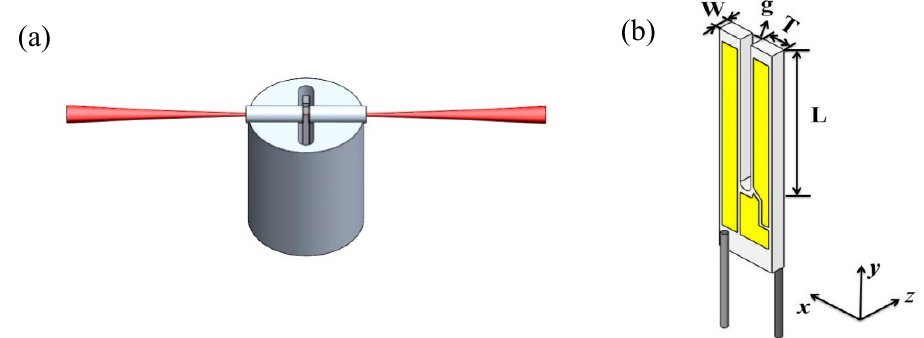
Figure 3. ( a ) A supporter to hold the AmR; ( b ) The length L, the thickness T, the width W and the prong spacing g of a standard QTF.